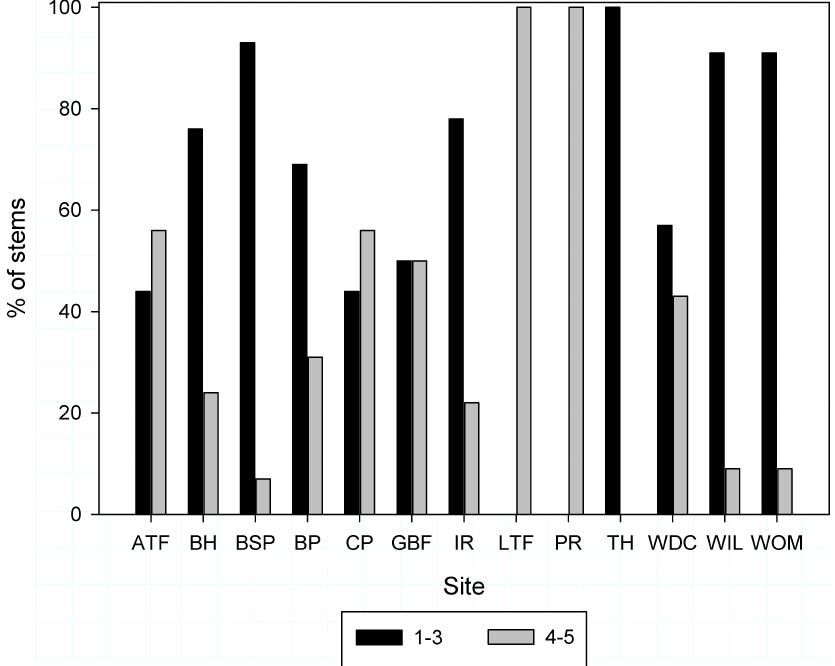
Figure 2. Percentages of dead trees grouped by snag classes 1–3 (black bars) and snag classes 4 and 5 (gray bars) at all 13 sites in eastern Massachusetts; ATF = Amesbury Town Forest; BH = Blue Hills State Reservation; BSP = Borderland State Park; BP = Bradley Palmer State Park; CP = Centennial Park; GBF = Great Brook Farm State Park; IR = Iron Rail Town Park; PR = Profile Rock State Park; TH = Turkey Hill Conservation Area; WDC = Wildcat Conservation Area; WIL = Willowdale State Forest; WOM = Wompatuck State